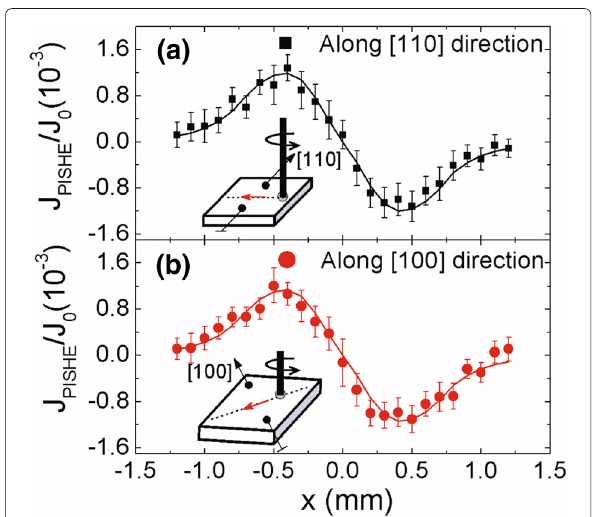
Fig. 5 The normalized PISHE current collected along different crystal orientations. The PISHE current is normalized by the photocurrent under a bias of 0.3 V. The solid symbols are the experimental data, and the solid lines are the theoretical fitting results. The insets show the schematic diagrams for the corresponding measurement geometries